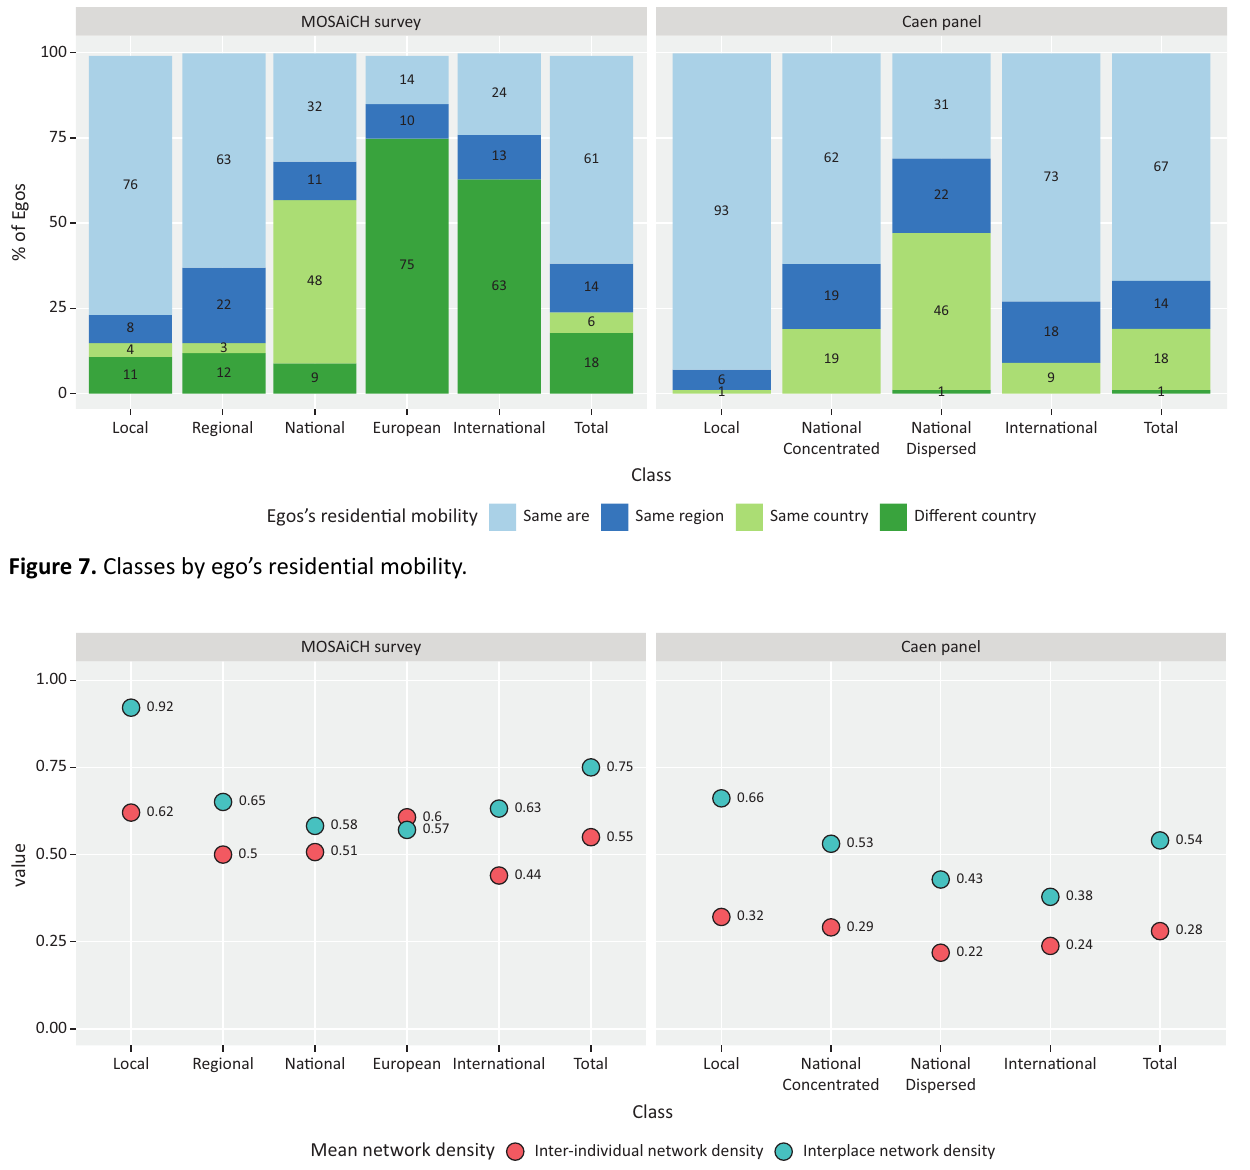
Figure 8. Mean density of ego’s inter‐individual and inter‐area